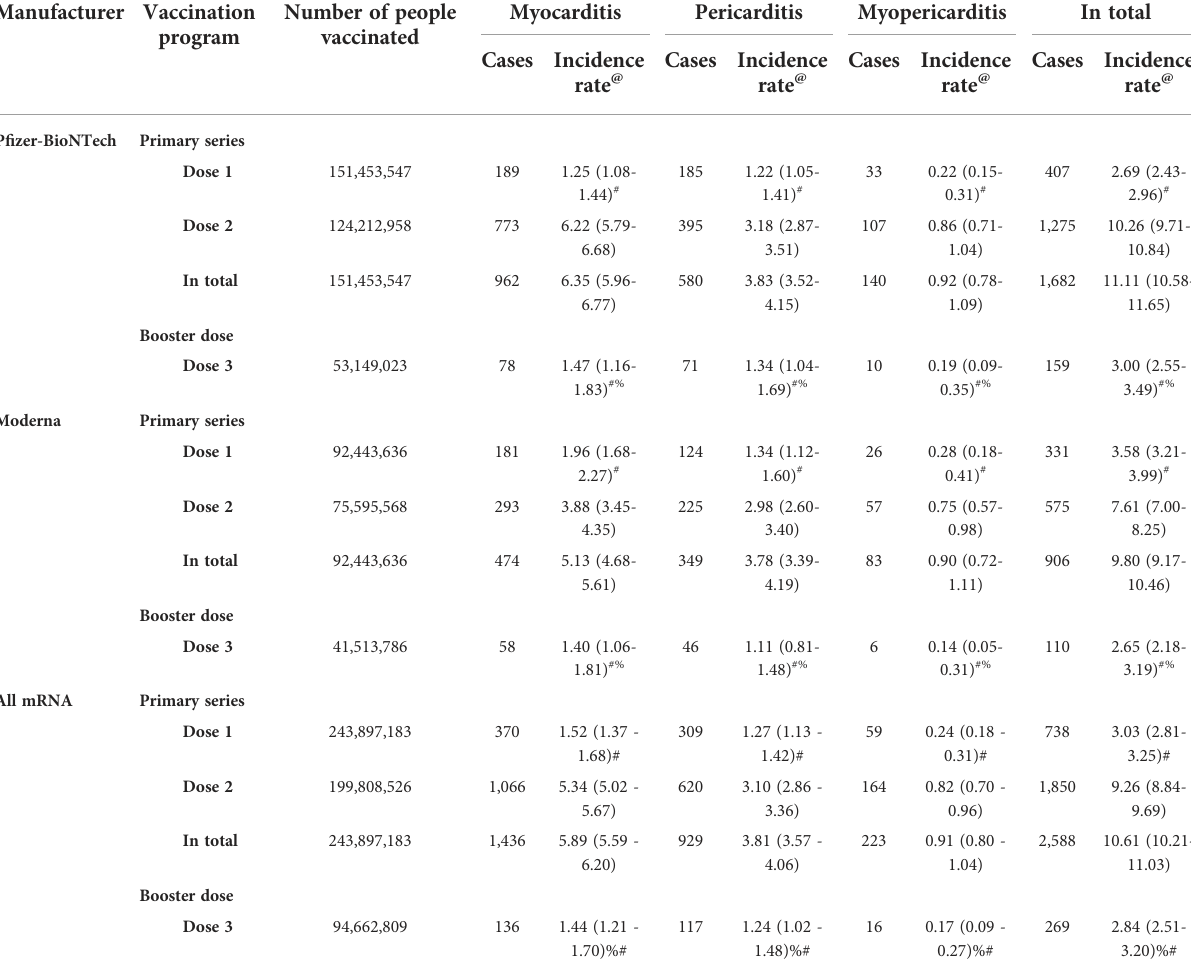
TABLE 2 The incidence rate of cases of myocarditis/pericarditis by different mRNA COVID-19 vaccination programs based on number of people vaccinated. Manufacturer